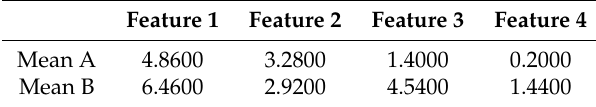
Table 9. The mean values calculated from the first five